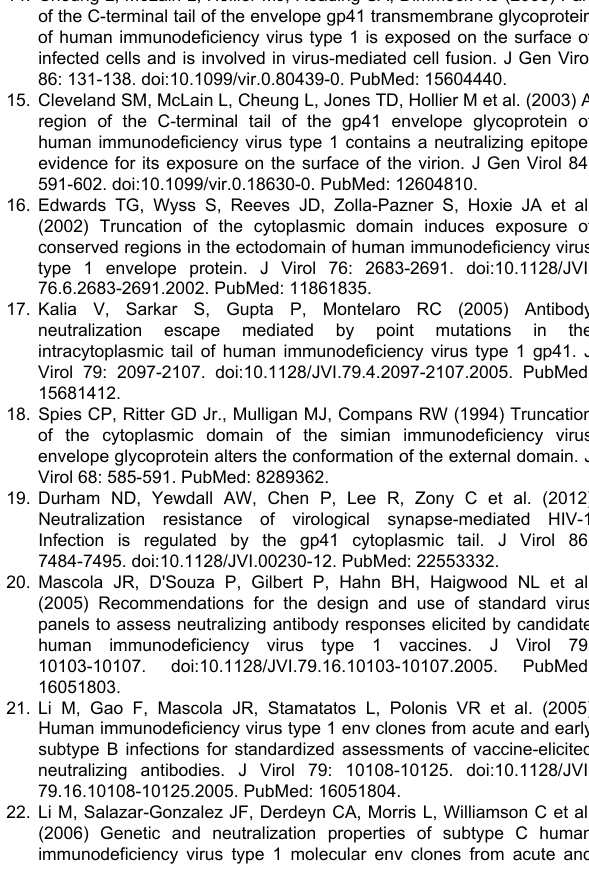
Figure S2. p24-standardized titration in TZM-bl cells of CM235.2 Env-based viruses and of ETH2220.11B Env- based viruses. The different viral forms expressing Env of CM235.2 (A) and ETH2220.11B (B) were compared using a standardized p24 virus input: virus stocks of pseudovirus, biological isolate, parental IMC, and IMC.LucR were assessed for p24 concentration (C and D). Starting with a dose of 25 ng/ml of each virus stock, a 4-fold serial dilution was used to infect TZMbl cells in duplicate. Firefly luciferase activity was measured 48 hours later. The horizontal bold line represents RLU FF cut off.